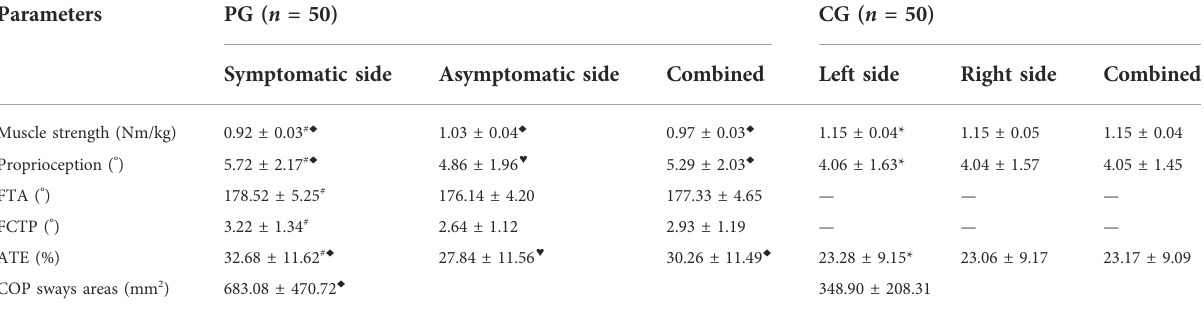
TABLE 2 Comparison of parameters between the two groups ( n =